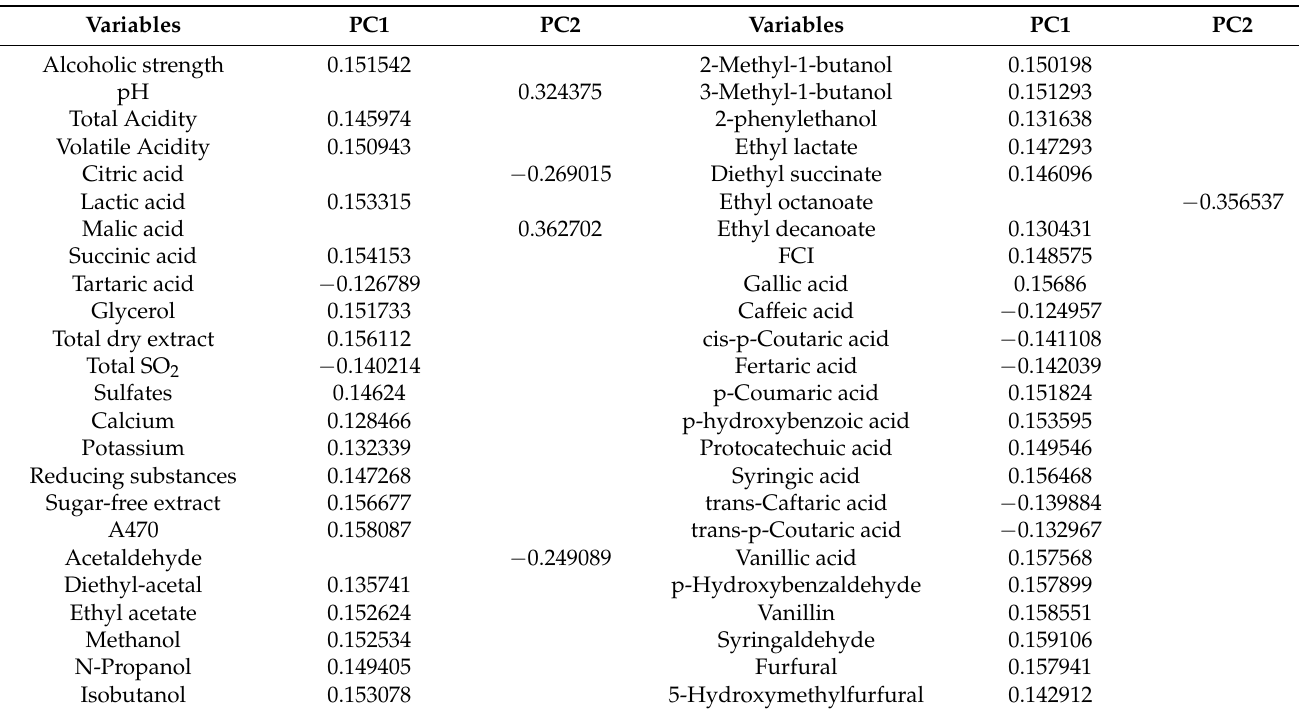
Table 10. Coefficients of principal components 1 (PC1) and 2 (PC2) of the variables that have shown the highest correlation (r > 0.12 in PC1 y > 0.24 in